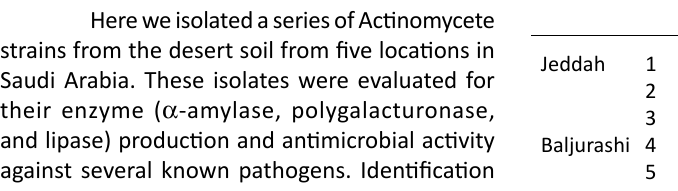
Table 1. Locations of the samples Location GPS No. of reading